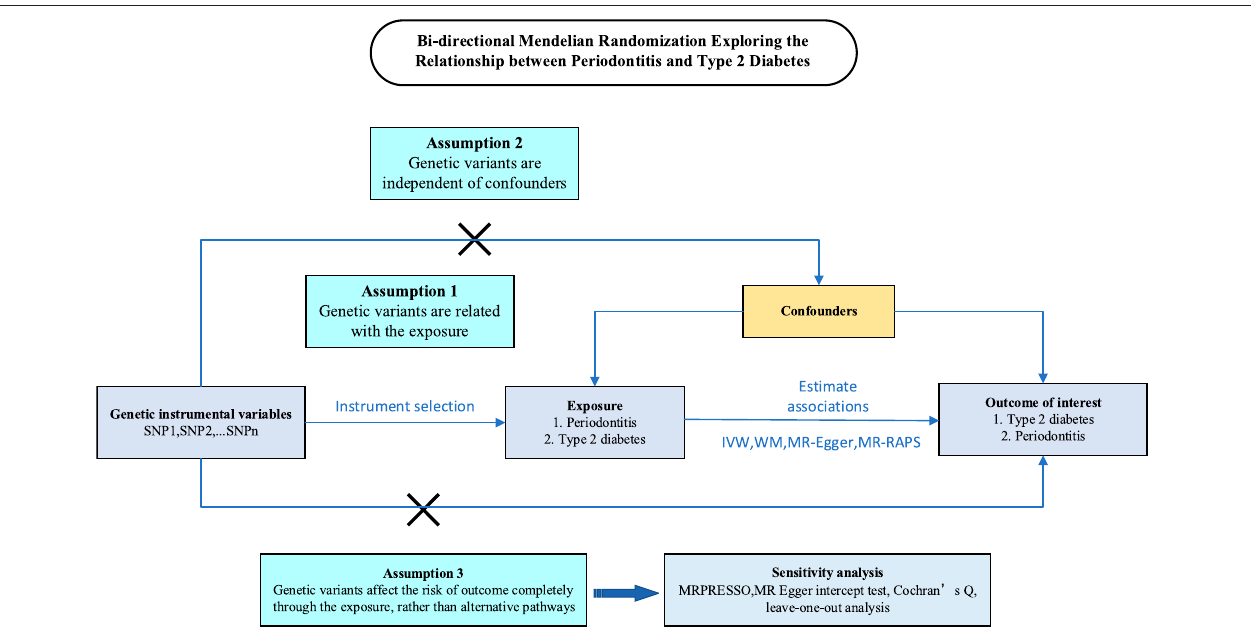
FIGURE1| Schematicsforthebidirectional Mendelianrandomizationdesign. Mendelianrandomizationrequiresvalidgeneticinstrumentalvariants satisfyingthree assumptions.